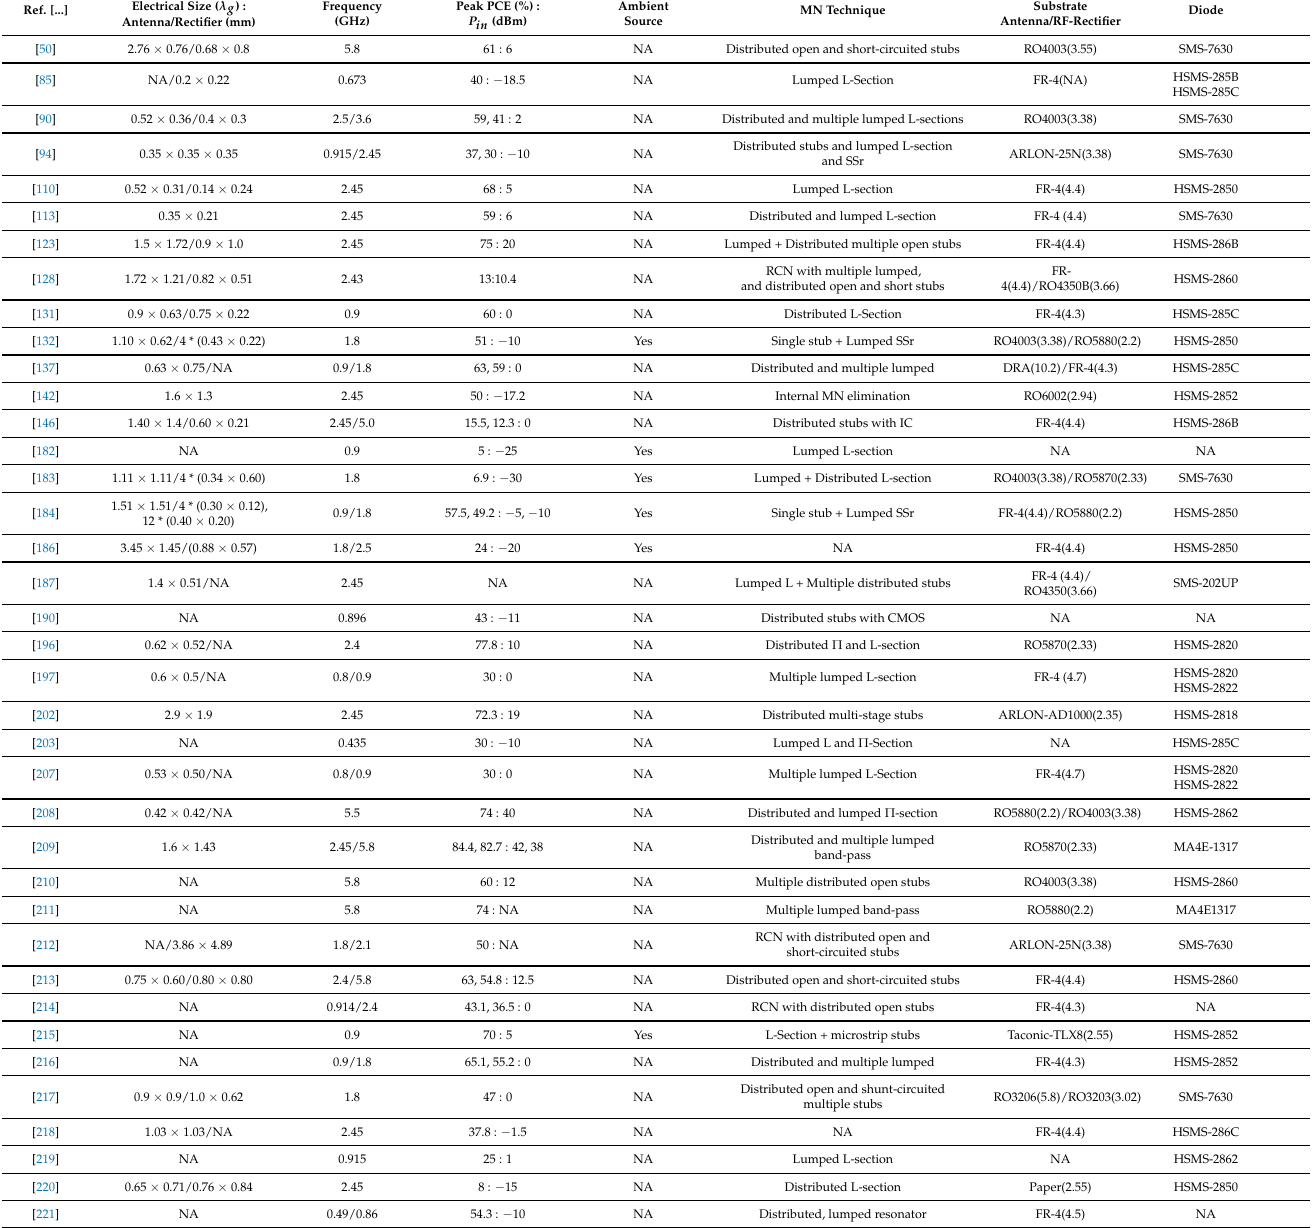
Table 3. Comparison of some basic single-band and dual-band RFEH